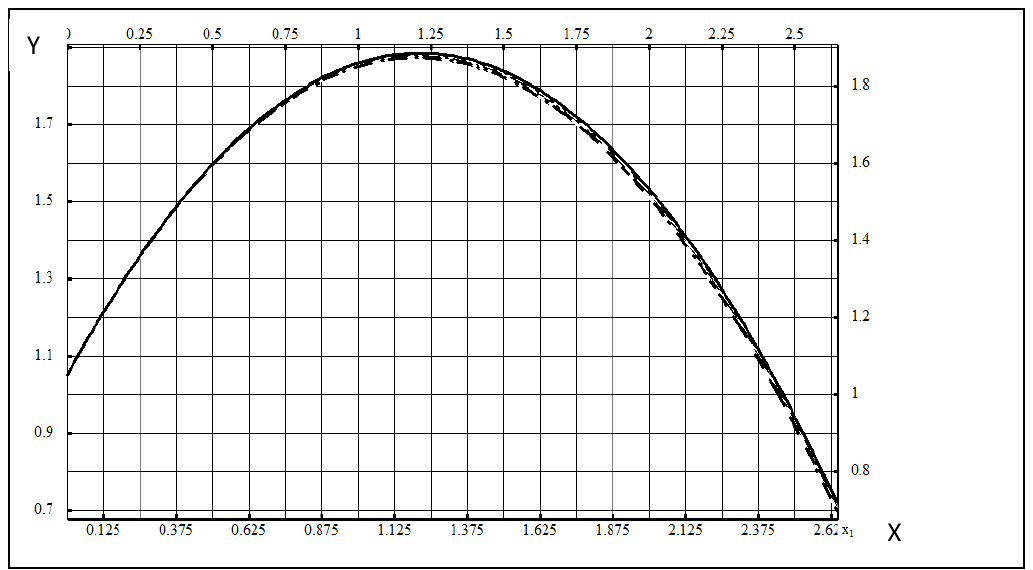
Fig. 7. Characteristic curves of masses center trajectory for different values of air resistance